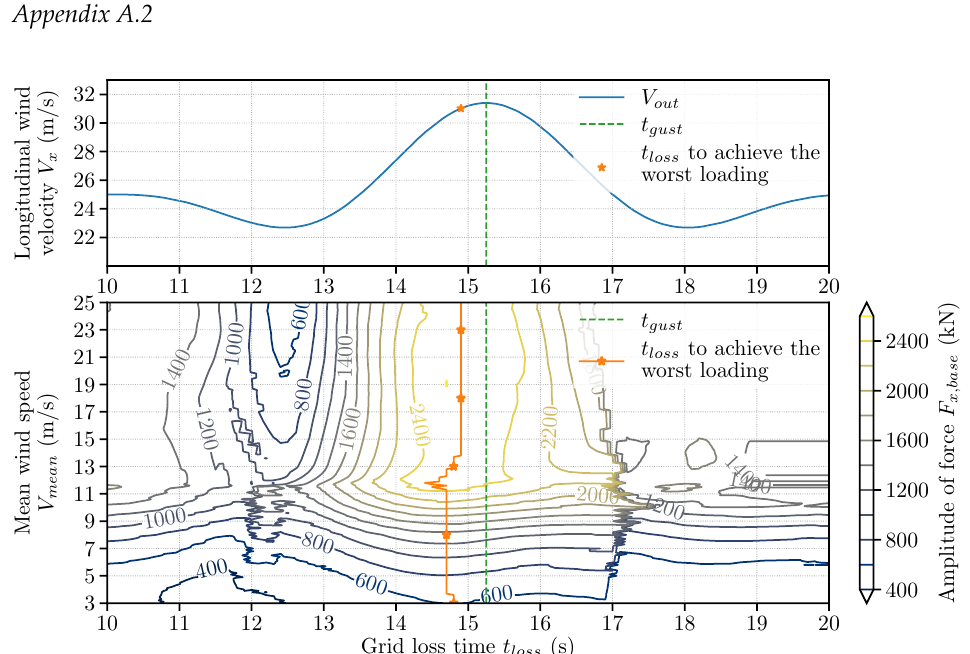
Figure A1. Grid loss timing in the range of operating wind speed with reference to tower force. The upper line plot gives an example of wind speed of gust at mean wind speed V mean = V out = 25m/s. The lower contour plot shows the peak-to-peak amplitude in relation to the mean wind speed V mean and the grid loss time t loss .